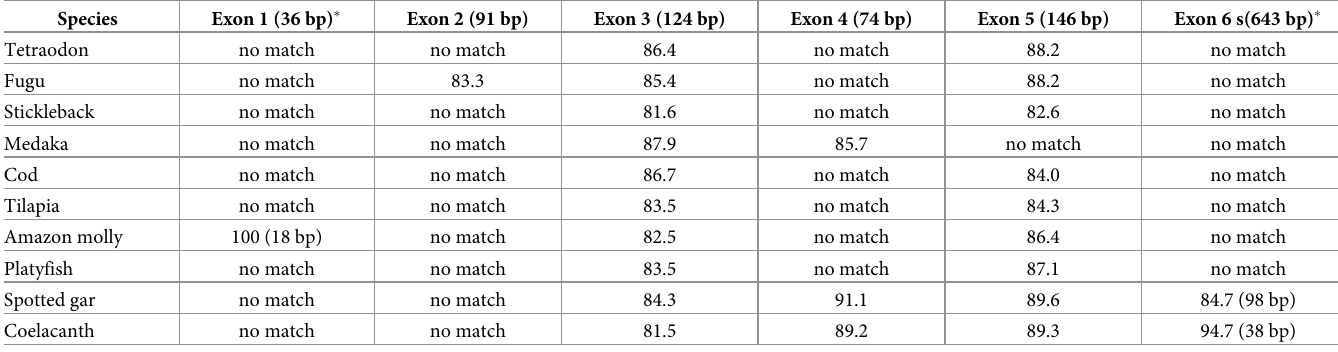
Table 7. Nucleotide identity with zebrafish Zmat2 exons.